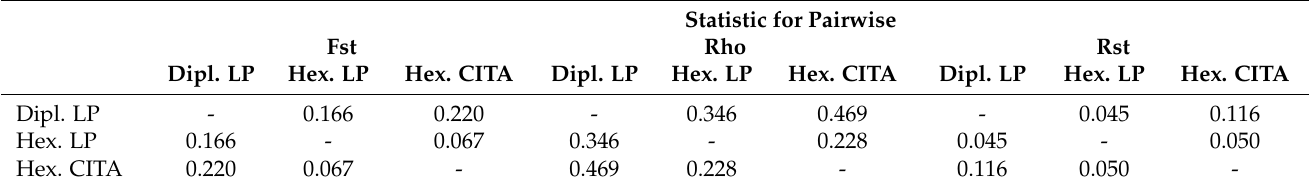
Table 4. Statistics for pairwise groups differences. Measure of population differentiation (intraclass kinship coefficient) (Fst), intraclass relatedness coefficient (Rho) and Fst analogue based on allele size (Rst), all with the ANOVA